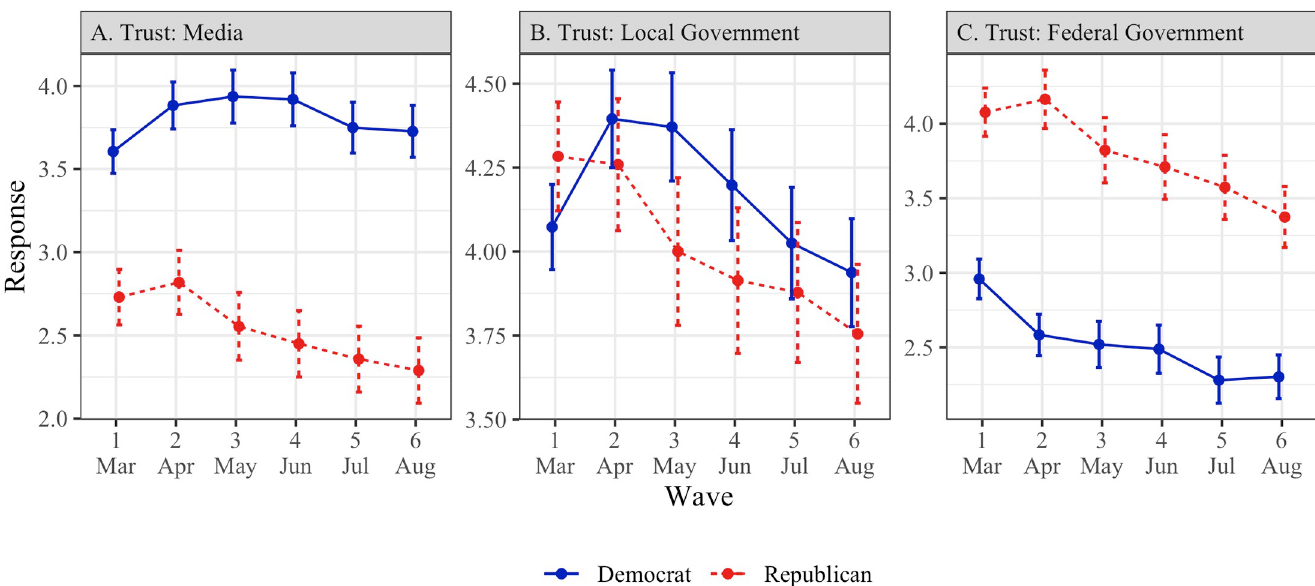
Fig 3. Trust in broad institutions by political affiliation (March–August 2020). Points represent means, and error bars represent 95% confidence intervals. All scale responses range from 1 to